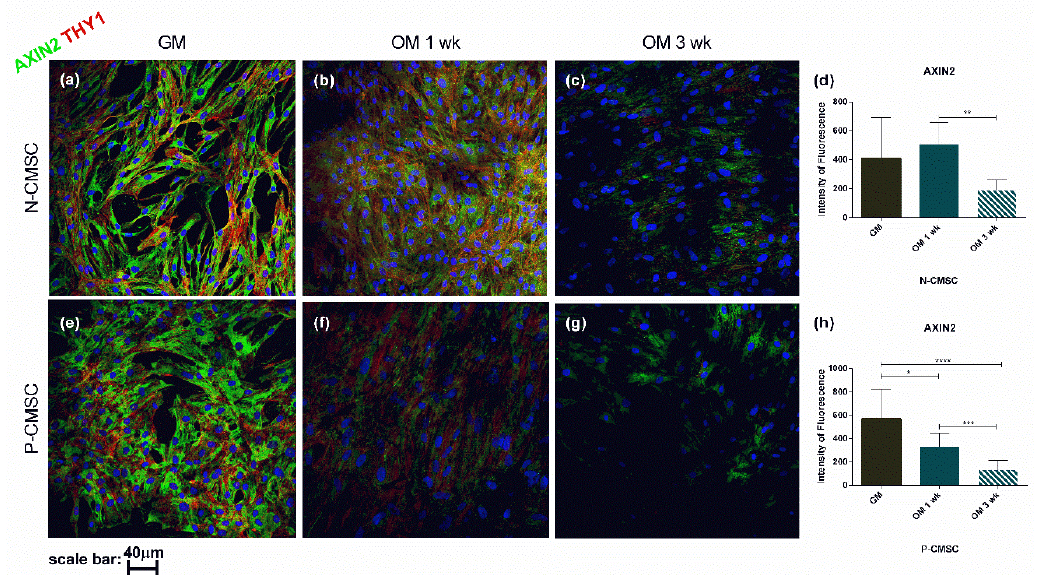
Figure 8. Expression of AXIN2 and THY1 in CMSC during osteogenic induction. Markers’ expression analysed by immunofluorescence in ( a – c ) N-CMSC and ( e – g ) P-CMSC, cultured with osteogenic medium (OM) for one (1 wk) and three weeks (3 wk), compared to cells cultured in growth medium (GM). Nuclei are stained in blue with DAPI. The intensity of fluorescence has been quantified by the ImageJ software for both ( d ) N-CMSC and ( h ) P-CMSC. * p < 0.05; ** p < 0.01; *** p < 0.001; **** p < 0.0001.